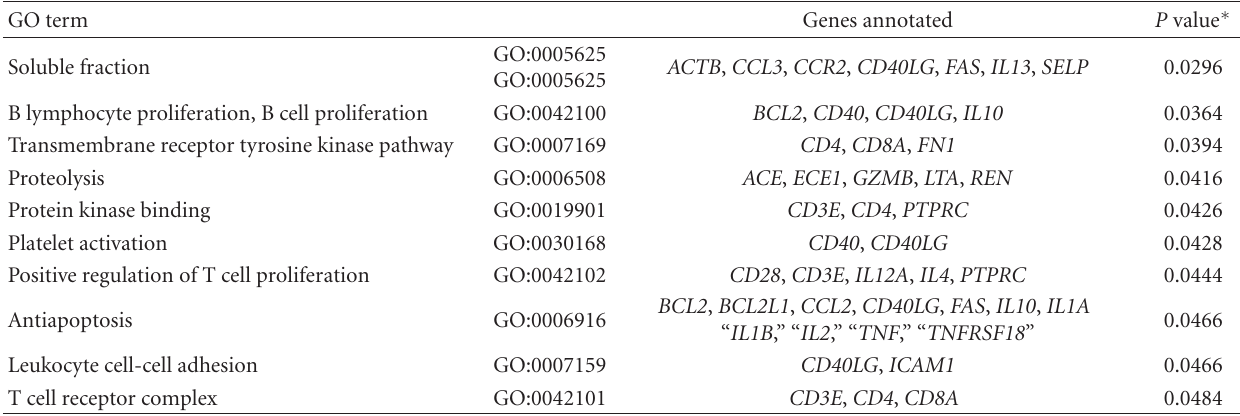
Table 3: Biological networks within graft tissue associated with asymptomatic BK